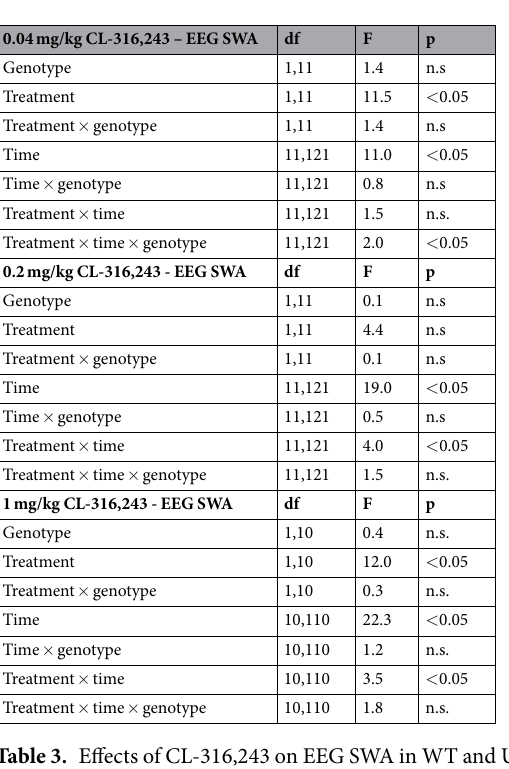
Table 3. Effects of CL-316,243 on EEG SWA in WT and UCP-1 KO mice – statistical results.